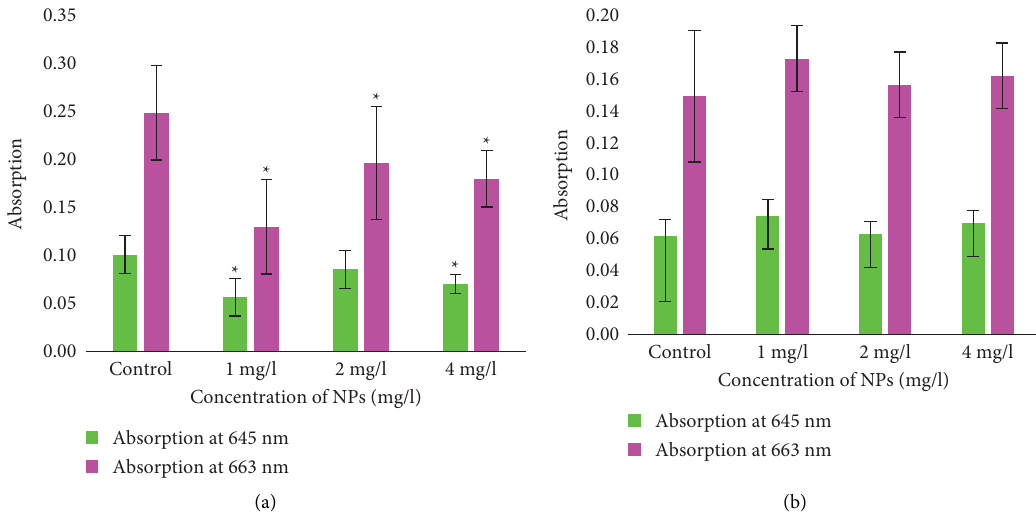
Figure 4: Absorption of common wheat ( Triticum aestivum L.) at 645nm (for chlorophyll b) and 663 nm (for chlorophyll a) 15 days after treatment with Fe3O4 (a) and ZnO (b) nanoparticles. Te values are the mean of three replicates with the standard deviation. ∗ indicates a statistically signifcant diference ( P < 0.05) compared to the